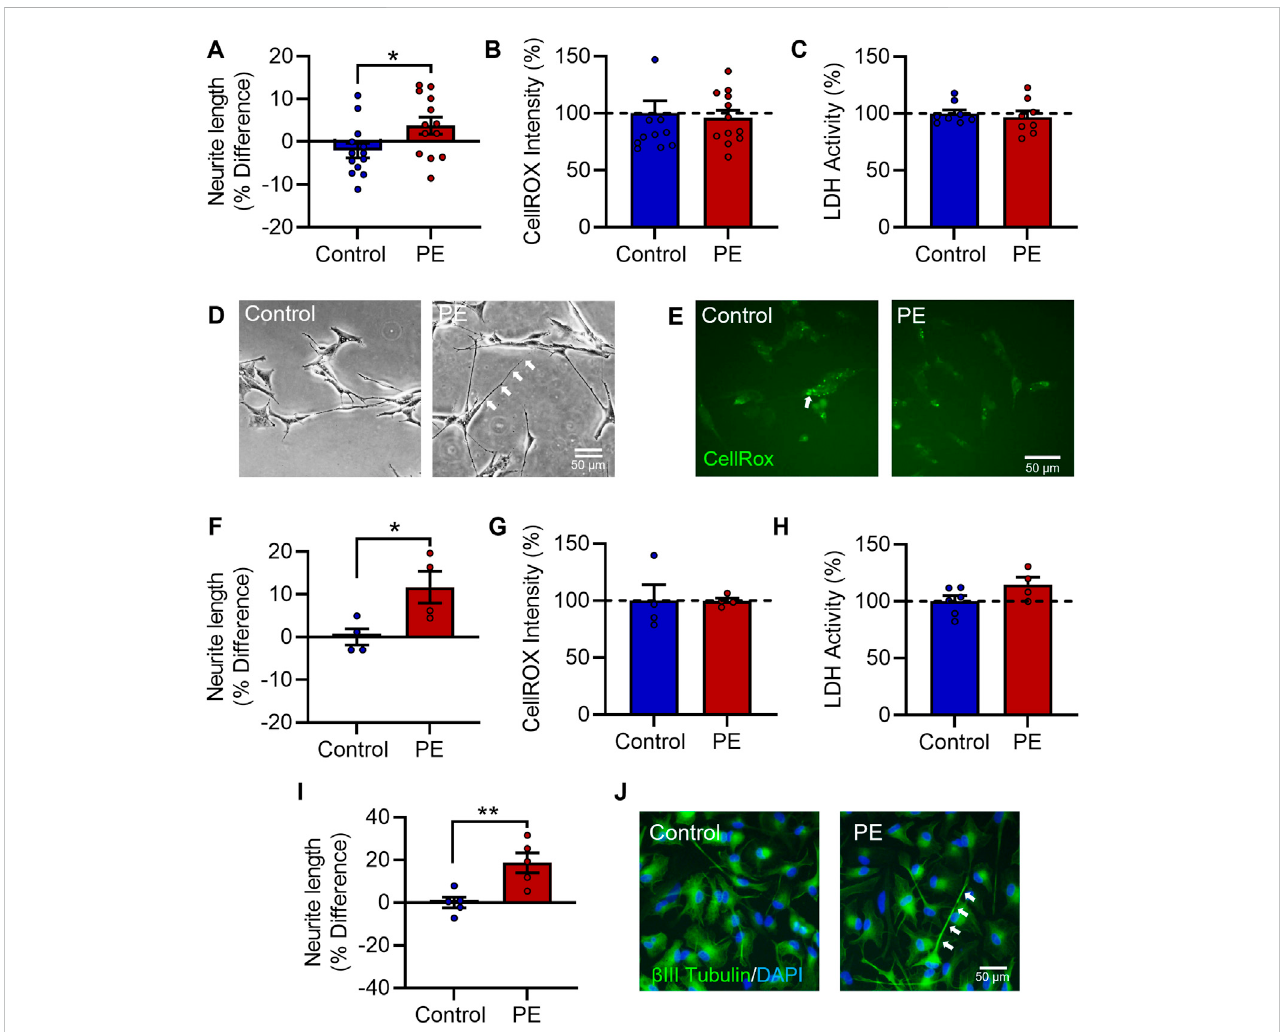
FIGURE 1 Pre-eclampsia serum increases neurite growth in differentiated SH-SY5Y Cells. RA-differentiated SH-SY5Y cells were treated with 3% (v/v) serum from pre-eclamptic patients (PE) or normotensive pregnant controls for 72 h. (A – C) Graphs of (A) neurite growth, (B) CellROX ™ Green Reagent fl uorescent intensity asameasureof oxidative stress,and (C) extracellularLDH activity as ameasure ofcytotoxicity. (D,E) Representative photomicrographs of (D) neurite growth, imaged under phase contrast, and (E) CellROX ™ green reagent fl uorescent intensity, 72 h after serum treatment. (F,G) SH-SY5Y cells were neuronally differentiated with 10 µM RA daily for 5 days and 50 ng/mL BDNF daily for 7 days, with 3% (v/v) serum from pre-eclamptic patients (PE) or normotensive pregnant controls for the last 3 days in vitro , and assessed for (F) neurite growth, (G) oxidative stress, and (H) cytotoxicity. (I,J) Graph and representative photomicrographs of neurite growth in serum-exposed ReNcell ® VM cells stained for β III tubulin (green) reactivity and bisbenzimide (blue). Data are mean+SEMfrom thirteen, twelve,or eightserum samplesper group for (A – C) ,respectively ( n =13; n =12; n = 8); four pergroup for F-H( n = 4); and fi ve per group for (I,J) ( n = 5). Student ’ s unpaired t -test for A, (F – I) , Mann-Whitney test for (B – C) (* p < 0.05, ** p < 0.01 vs.